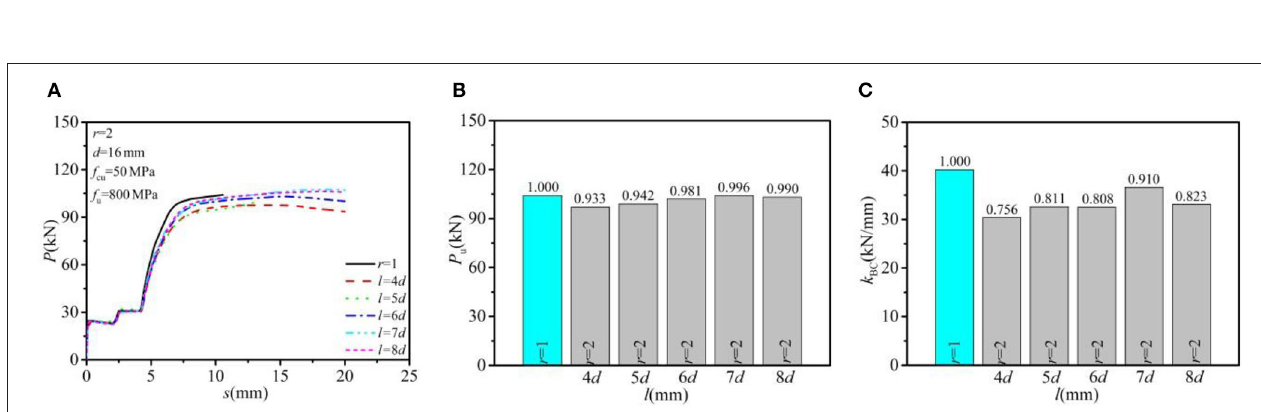
FIGURE 7 | Effect of bolt spacing: (A) load–slip relationship; (B) shear-bearing capacity; and (C) shear stiffness.